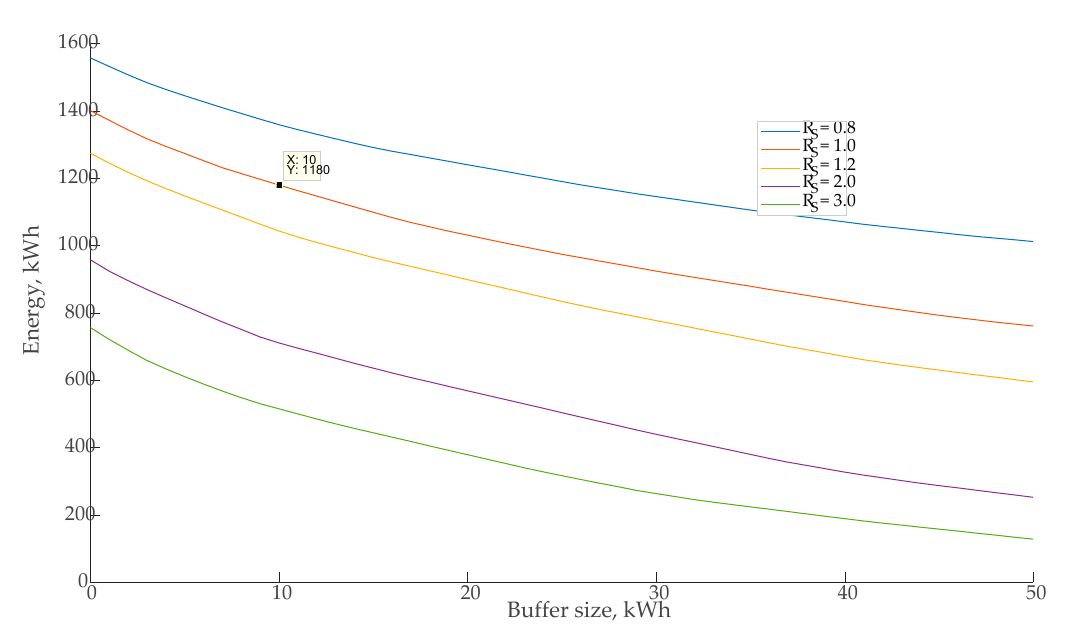
Figure 6. Energy from the utility grid (UG) to microgrid—MG.